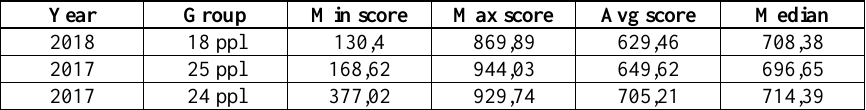
Table 2. Score of the students used STACK (maximum score: